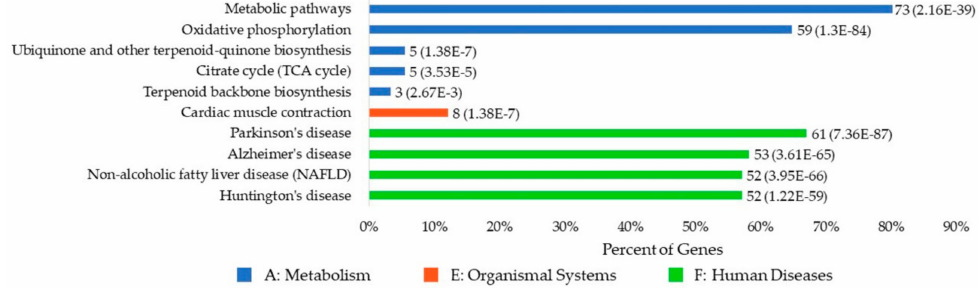
Figure 7. The top 10 significantly enriched KEGG (Kyoto Encyclopedia of Genes and Genomes) pathways of human UBPs. The description on the left side of the bar refers to the name of the KEGG pathway. “Percent of Genes” refers to the percentage of the number of genes involved in a given pathway compared to the total number of genes in the query proteins. The digital label on the right side of the bar of a gene term refers to the number of the genes involved in this pathway and the corresponding P-value. Di ff erent colors refer to the di ff erent categories of the pathways. Pathways of the same category are sorted by